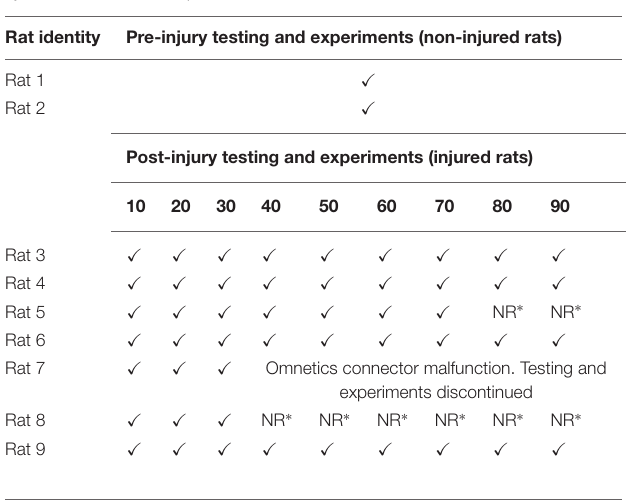
TABLE 2 | Success of conducting night experiments using the closed-loop system over select time